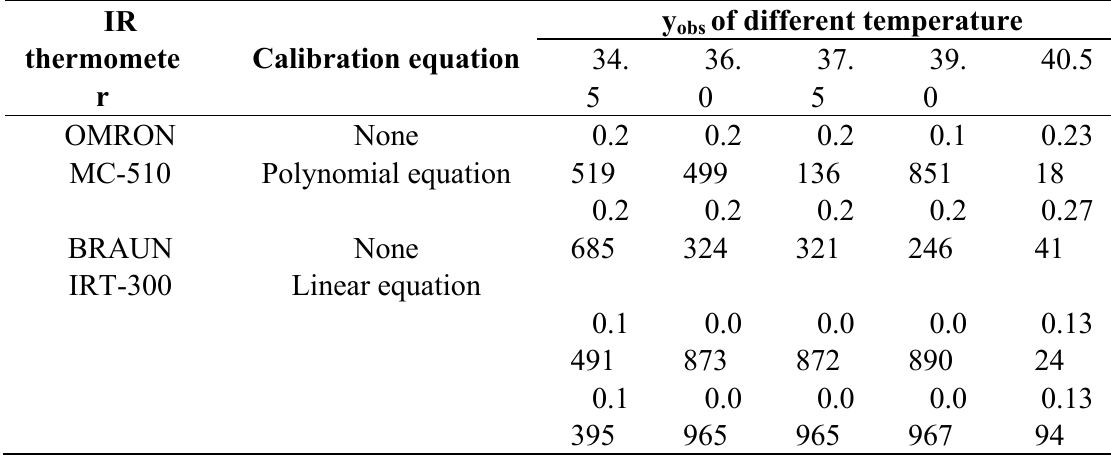
Table 7. The combined uncertainty for two IR